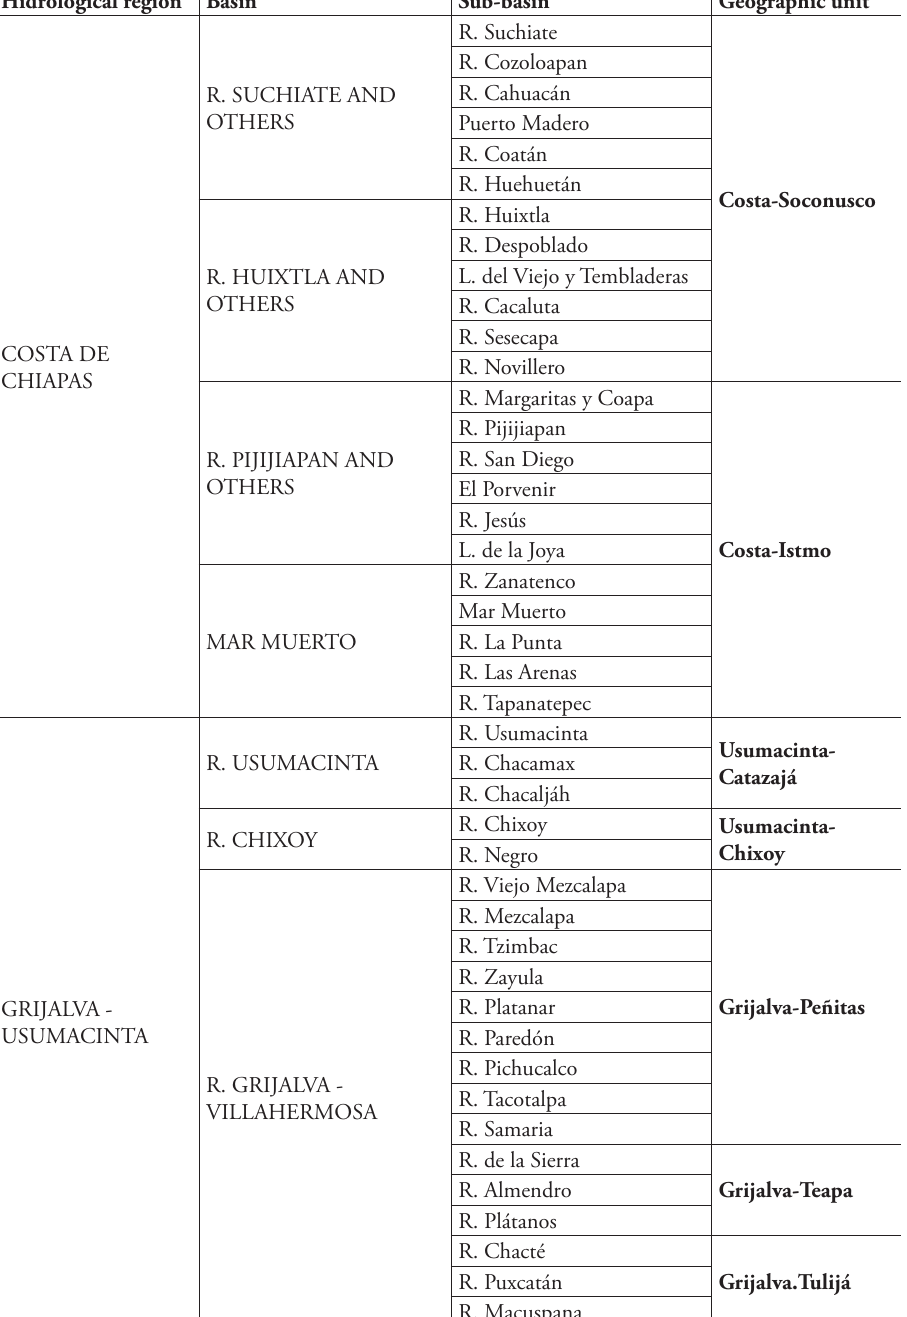
Table 1. Geographic units utilized to study the distribution of the fish fauna of Chiapas and sub-basins that form